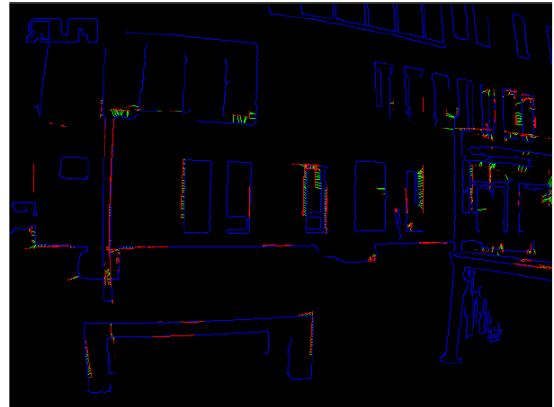
Figure 11: Thermal camera-LiDAR relative pose calibration: detected lines in the thermal image (blue), in the point cloud (red) and correspondences between points sampled from them (green).